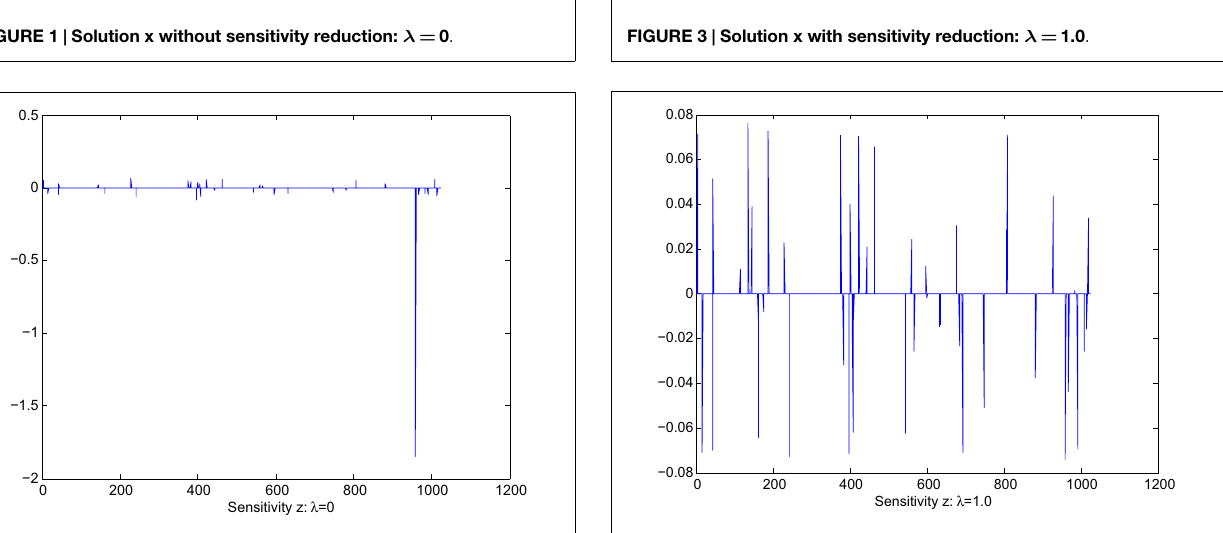
FIGURE 4 | Sensitivity Z with sensitivity reduction: (cid:21) = 1.0